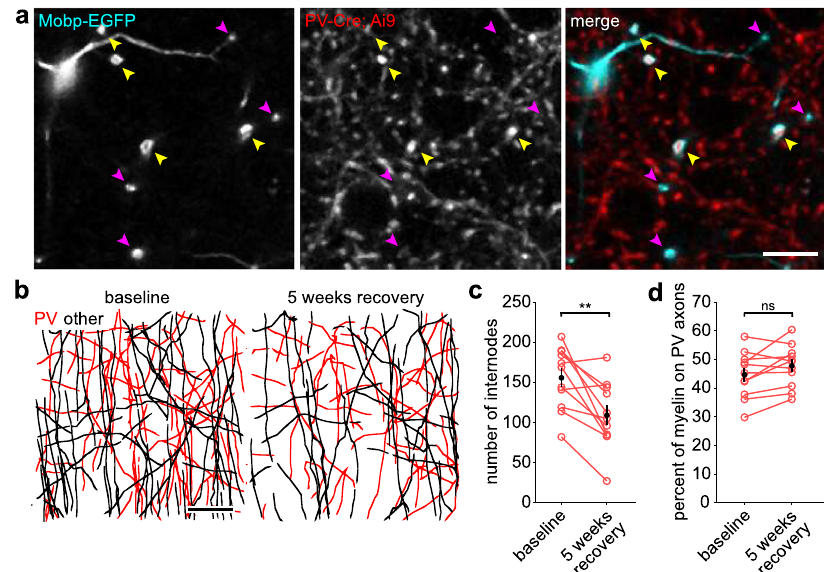
Fig. 6 PV axons are not preferentially remyelinated in regions with reduced oligodendrogenesis. a In vivo image of layer II/III somatosensory cortex acquired from a Mobp-EGFP; PV-Cre; Ai9 mouse. Yellow arrowheads identify example sheaths surrounding PV axons, while magenta arrowheads identify sheaths surrounding non-PV axons ( “ other ” ). Scale bar, 10 μ m. b Example maximum XZ projection of an ROI (100 μ m × 100 μ m × 100 μ m) from layer II/III showing all traced internodes within the volume at baseline (left) and at 5 weeks recovery from cuprizone (right). Red, sheaths surrounding PV axons; black, sheaths surrounding “ other ” axons. Scale bar, 20 μ m. c Total number of internodes within an ROI at baseline vs. 5 weeks recovery ( n = 10 ROIs (up to 2 ROIs from 2 imaged regions across 3 mice)) (** p = 0.003, paired two-tailed t -test). d Percent of traced sheaths surrounding PV axons within an ROI at baseline vs. 5 weeks recovery, same N s as in c (ns, not signi fi cant, p = 0.068, paired two-tailed t -test). All error bars represent standard error of the mean. Source data and statistical tests are provided as a Source Data fi